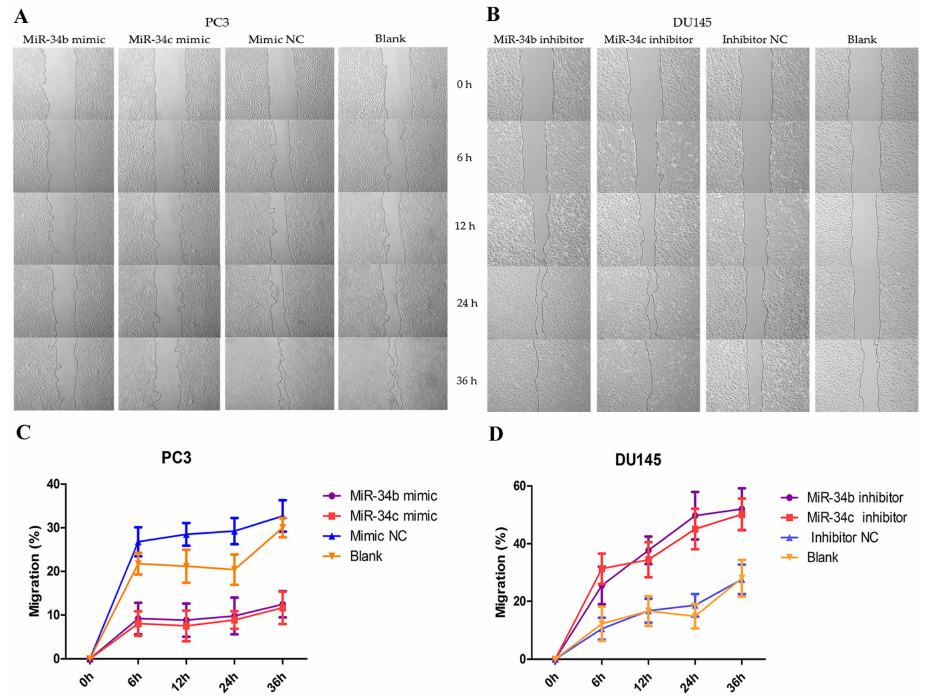
Figure 6. Random migration by a wound healing/scratch assay. ( A , B ) Shown are representative images of the scratch assay in DU145 and PC3 cells at 0, 6, 12, 24 and 36 h after the scratch was created; ( C , D ) The rate of migration calculated by the width of the wound in DU145 and PC3 cells after ectopic